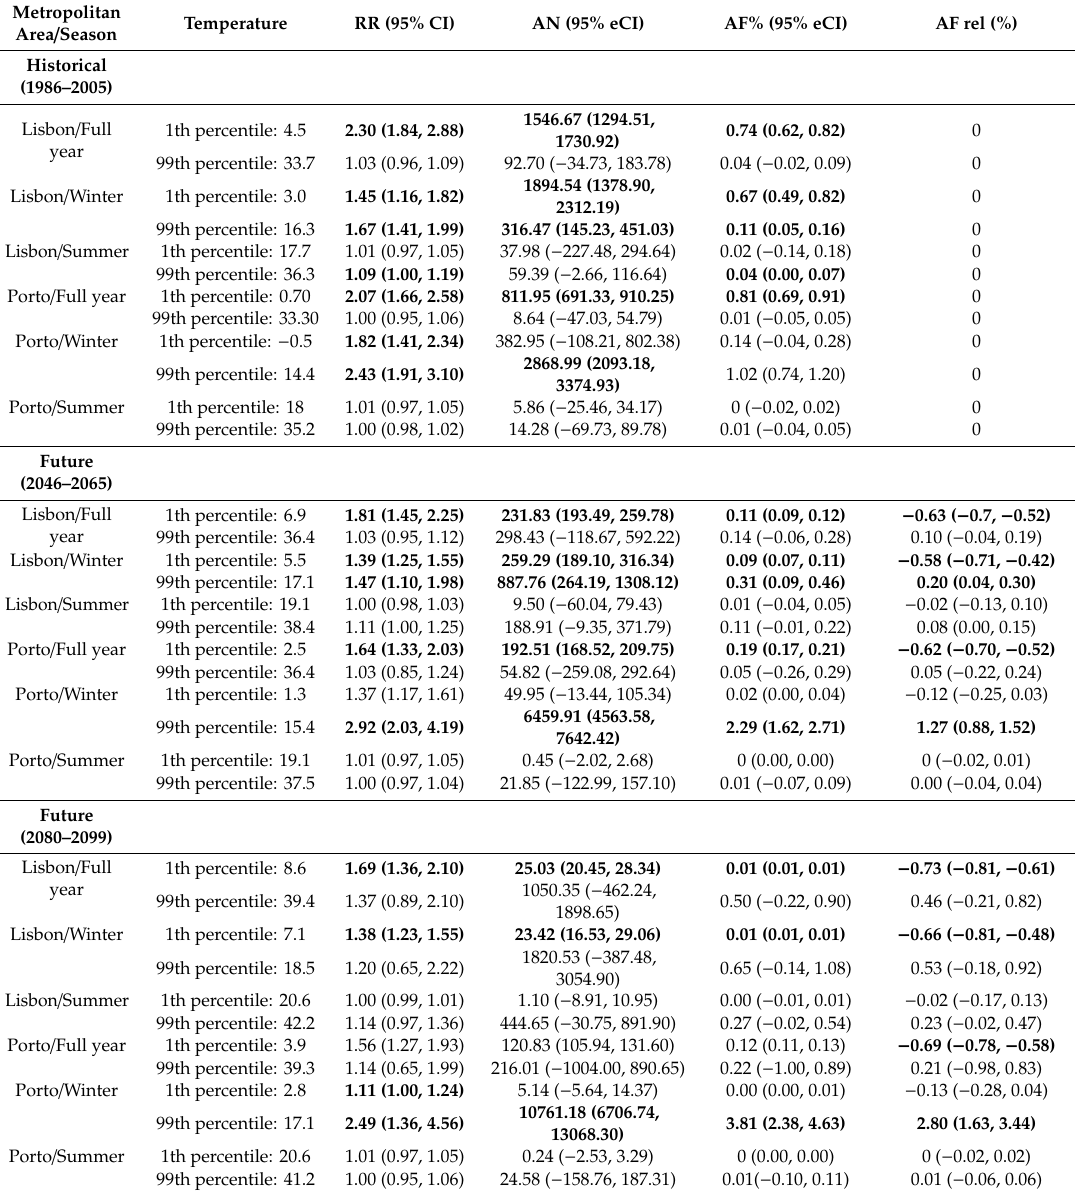
Table 2. Estimated risk (95% confidence interval), attributable mortality with 95% empirical CI, excess mortality attributable to temperature in the future periods (2046–2065 and 2080–2099) in relation to the historical period (1986–2005) evaluated at extreme